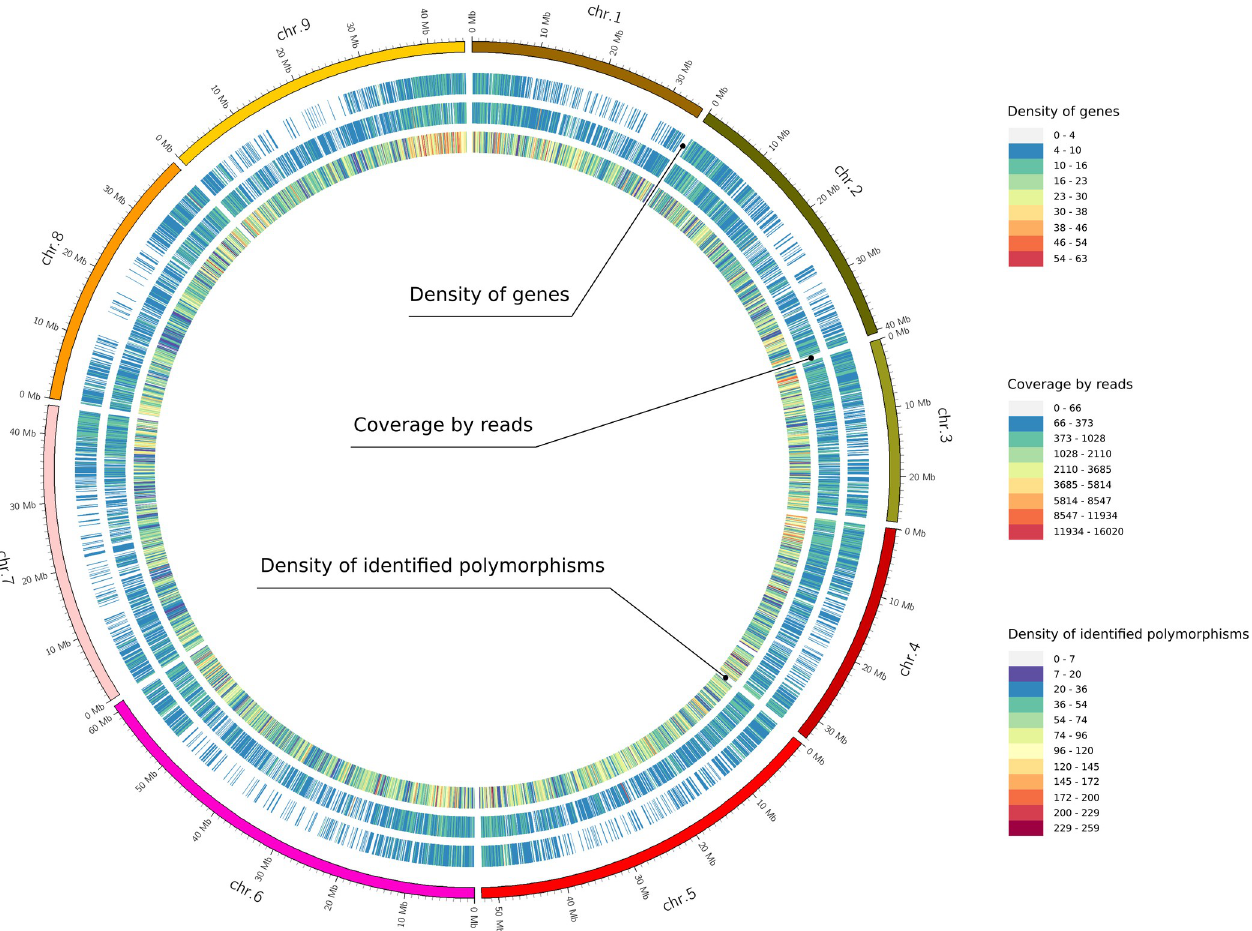
Fig 6. Beta vulgaris L. chromosomes overlaid with heatmaps showing gene density, coverage by reads and polymorphism density. The latter two parameters were determined in the presented here GBS experiment. All parameters were calculated using a 100 kb window. The data were visualized using Circos